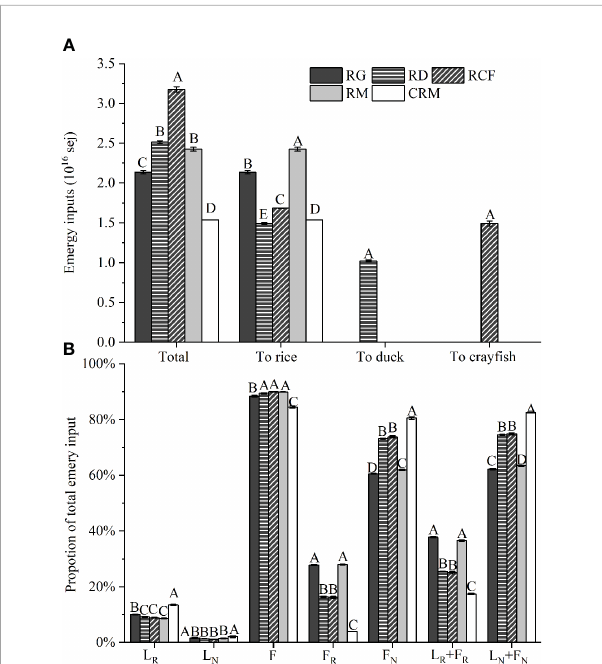
FIGURE 3 Emergy inputs (A) and the composition of total emergy input (B) to the fi ve rice production modes. RG, Rice-green manure rotation mode for organic rice production; RD, rice-duck coculture mode for organic rice production; RCF, rice-cray fi sh coculture mode for organic rice production; RM, rice monoculture mode for organic rice production; CRM, rice monoculture mode for conventional rice production. L R , local renewable emergy; L N , local nonrenewable resources; F, economic imported resources; F R , renewable fraction of purchased inputs; F N , nonrenewable fraction of purchased inputs; L R + F R , renewable emergy fl ows; L N + F N , nonrenewable emergy fl ows; In the same item (x-axis label), bars with the same uppercase letters are not signi fi cantly different according to the LSD test at P <